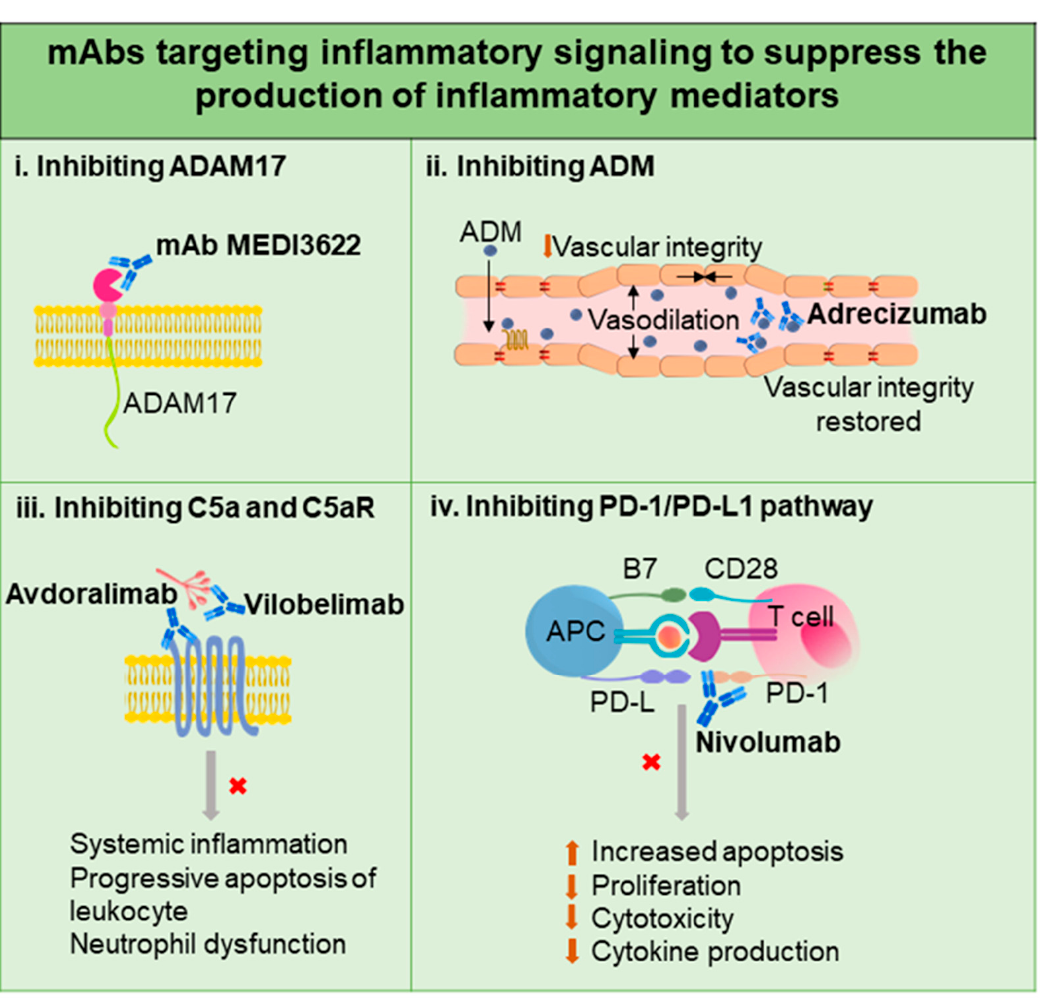
Figure 3. Immunomodulatory targets for the development of mAb to control the progression of sepsis.